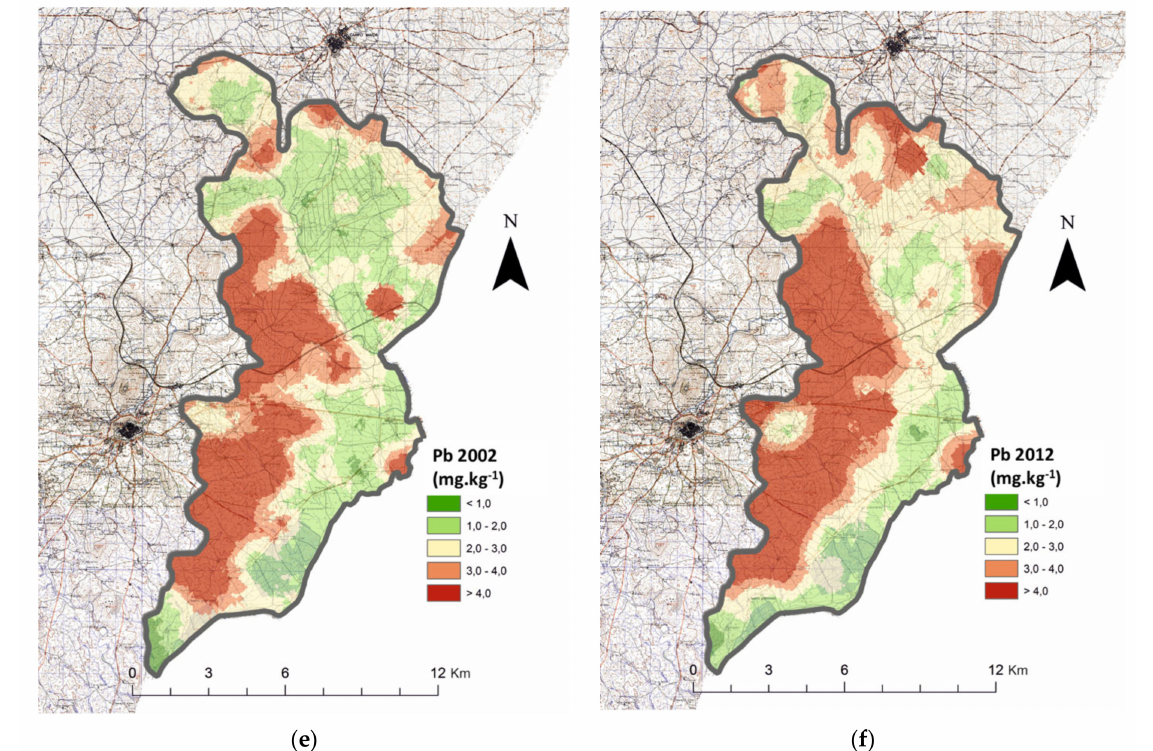
Figure 3. Predictive maps for available ( a ) Cd in 2002, ( b ) Cd in 2012, ( c ) Cr in 2002, ( d ) Cr in 2012, ( e ) Pb in 2002, and ( f ) Pb in